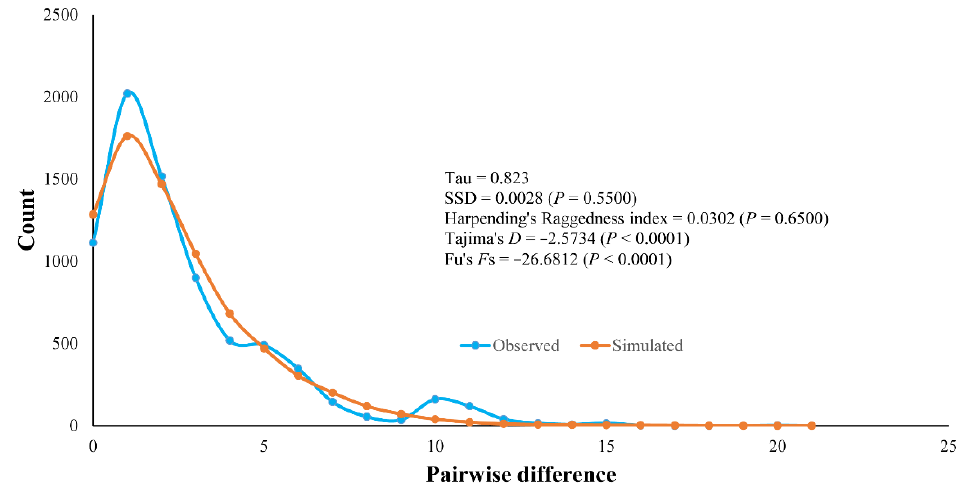
Figure 5. Mismatch distribution based on 123 mitochondrial cytochrome c oxidase I (COI) sequences of Culicoides mahasarakhamense in Thailand. Values of sum-of-square deviation (SSD), Harpending’s Raggedness index, Tajima’s D , and Fu’s F S tests are